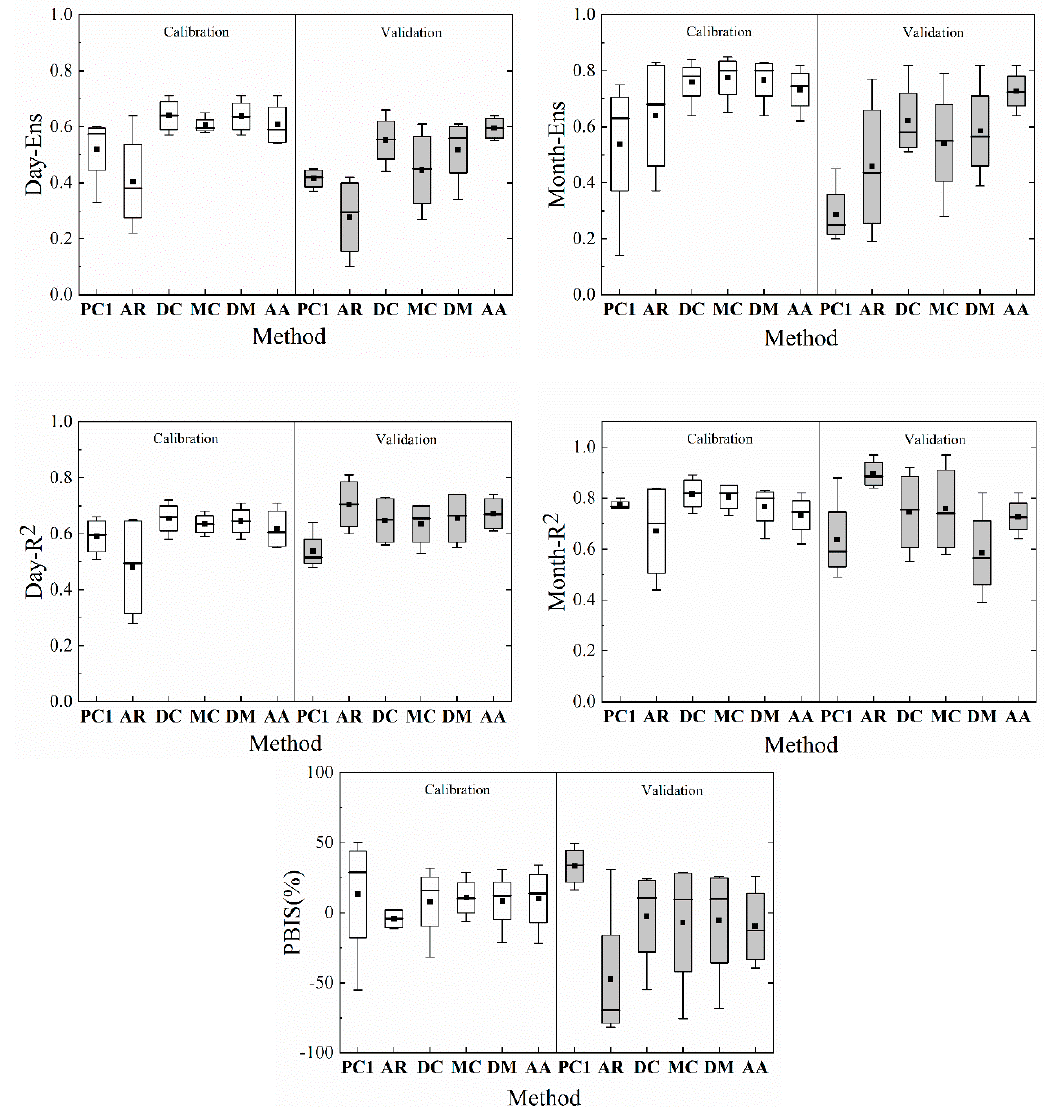
Figure 5. The distribution of the performance of the combined, parameter transfer, and area ratio methods in the four catchments